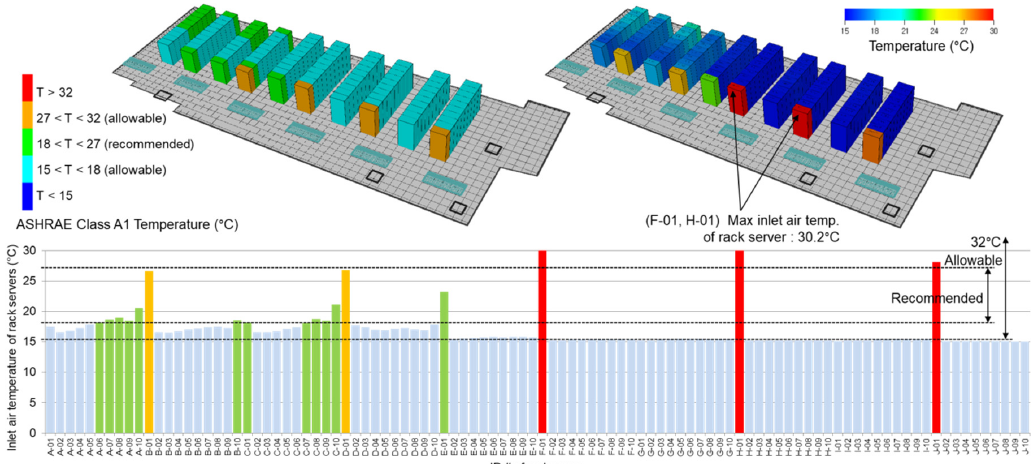
Figure 10. ALT-2 HAC with hard floor—the mean inlet air temperature of 100 server racks in normal cooling condition.